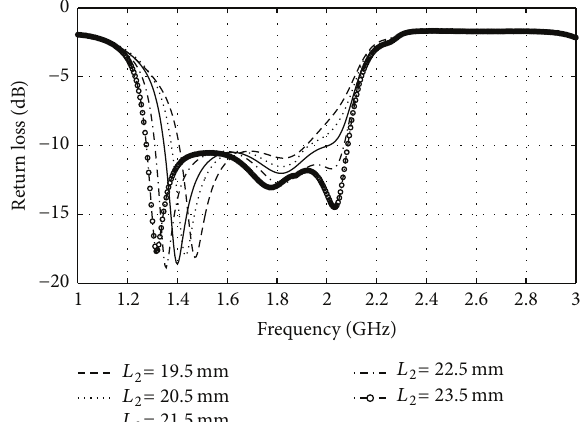
Figure 7: Effect of parasitic strip height on DRA impedance bandwidth (Case I, as mentioned in Table 1), with 𝑎 = 32 mm, = 30 mm, 𝑊 = 5.3 mm, 𝑏 = 29.6 mm, 𝑑 = 48.85 mm, 𝐿 1 1 = 1.5 mm, and 𝑀 = 20 mm and 𝑀 = 45 mm, 𝑇 = 2.95 mm, 𝑊 2 1 2 = 44.26 mm, 𝑠 = 1.575 mm, 𝑃 = 5 mm, and 𝐿 = 𝑊 = 𝑑 𝑑 sma th 130 mm. Figure 9: 2D radiation pattern for both cases mentioned in Table 1, with 𝑎 = 32 mm, 𝑏 = 29.6 mm, 𝑑 = 48.85 mm, 𝐿 1 = 30 mm, 𝑊 1 = = 22 mm, 𝑊 = 1.5 mm, and 𝑀 = 20 mm and 𝑀 = 5.3 mm, 𝐿 2 2 1 2 = 44.26 mm, 𝑠 = 1.575 mm, 𝑃 = 45 mm, 𝑇 = 2.95 mm, 𝑑 𝑑 sma th 5 mm, and 𝐿 = 𝑊 = 130 mm at 1.6GHz. The cross-polar values are too small to be visible in the above